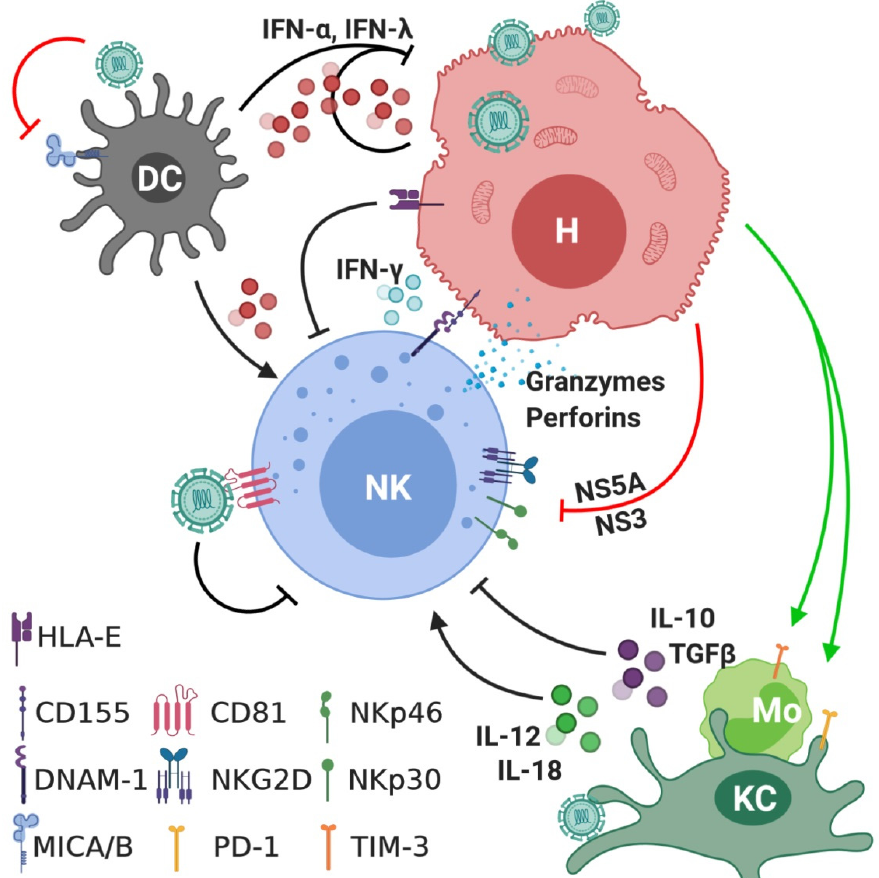
Figure 1. Hepatitis C virus (HCV)-mediated inhibition of NK function. In response to HCV infection, antiviral, immunomodulatory, and inflammatory cytokines such as IFN- α , IFN- λ , IL-12, and IL-18 are expressed by dendritic cells (DCs), hepatocytes (H), and myeloid populations both in circulation (monocytes, Mo) and within the liver (Kupffer cells, KC). Upon recognition of HCV-infected hepatocytes via DNAM-1, NK cells produce IFN- γ and release their cytotoxic granules to inhibit viral replication and kill infected cells, respectively. To minimise this NK response, viral proteins NS5A and NS3 reduce surface expression of activating receptors NKG2D, NKp30, and NKp46, whereas NKG2D ligands MICA/B are downregulated on DC populations. Moreover, core protein upregulated hepatocyte HLA-E that interacts with inhibitory NK receptor NKG2A and E2 interaction with CD81 inhibits NK cell IFN- γ production and cytotoxicity. Lastly, NK cell activating IL-12 and IL-18 secretion from monocytes and macrophage populations is reduced due to NS5A-mediated IL-10 production as well as HCV-mediated upregulation of PD-1 and Tim-3. Green line, upregulated expression; red line, downregulated expression.